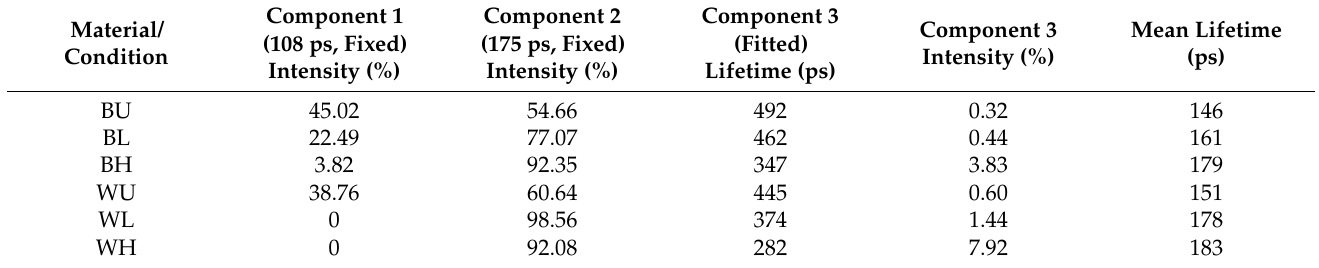
Table 3. Best-fit parameters derived for the three-component model with two fixed lifetimes.